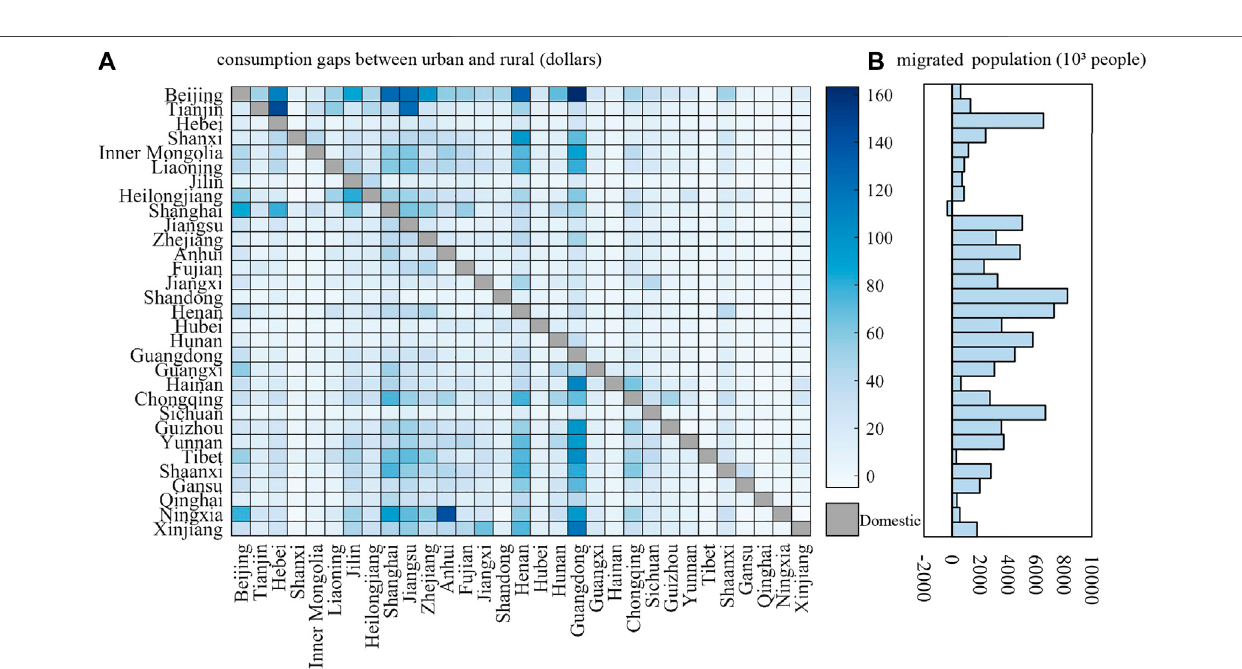
FIGURE8| Thegapsbetweenpercapitaurbanandruralconsumptionlevelsduring2012to2017 (A) ,andthepopulationmigratedfromruraltourbanduring2012 to 2017 (B) .